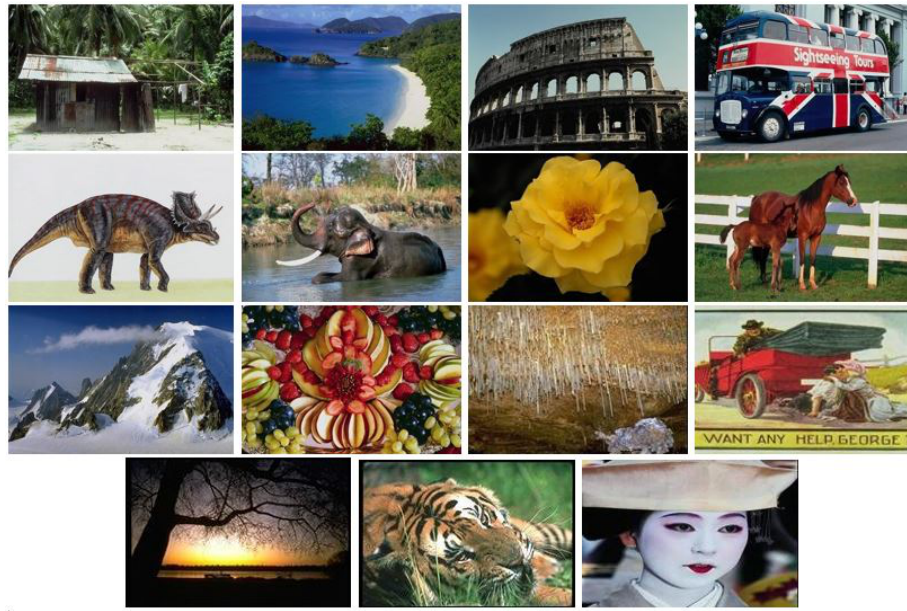
Figure 5. Randomly selected images from each class of Corel-1K and Corel-1.5K image datasets [40].